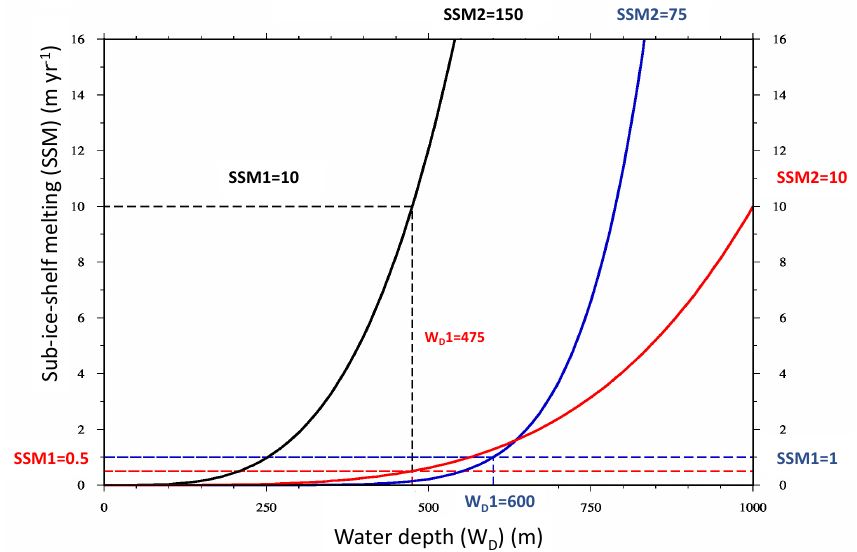
Figure 3. Schematic illustration of three examples of the SSM parameterization.